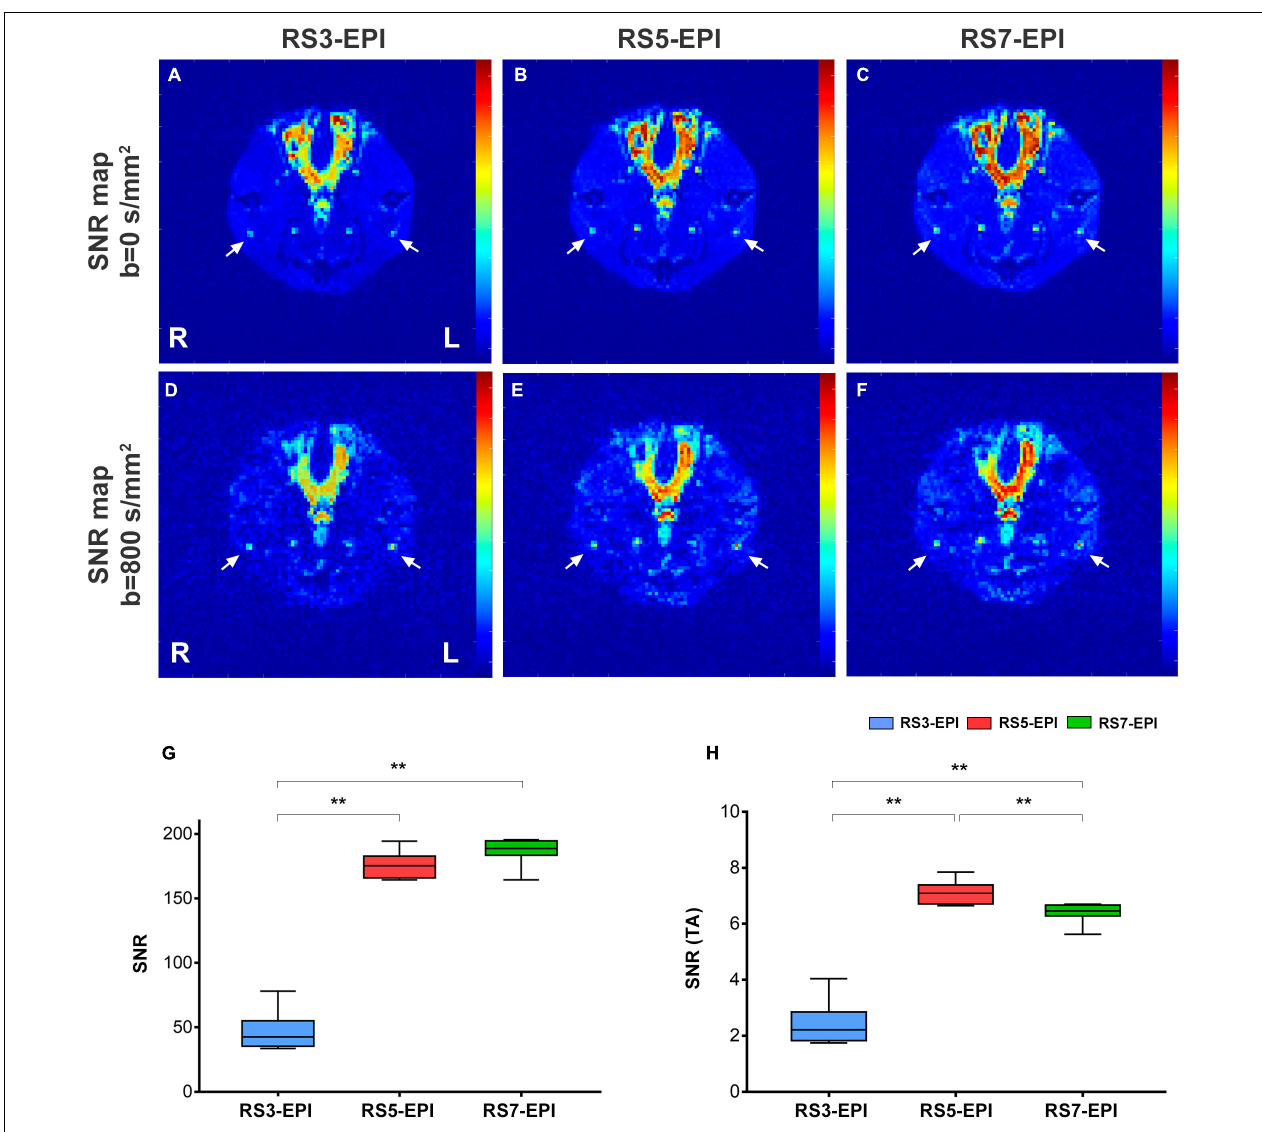
FIGURE 2 | SNR maps (A–F) , SNR value (G) , and SNR (TA) value (H) for RS3-EPI, RS5-EPI, and RS7-EPI. The measured SNR value increases with increasing segmented (G) for the three EPI sequences. Regarding SNR-values corrected for the acquisition time, RS5-EPI yielded significantly higher SNR than RS3-EPI and RS7-EPI (H) . SNR, signal-to-noise ratio; SNR(TA), SNR Correction due to sequence-specific differences in acquisition time (H) . ** P ≤ 0.017, post hoc analysis with Bonferroni